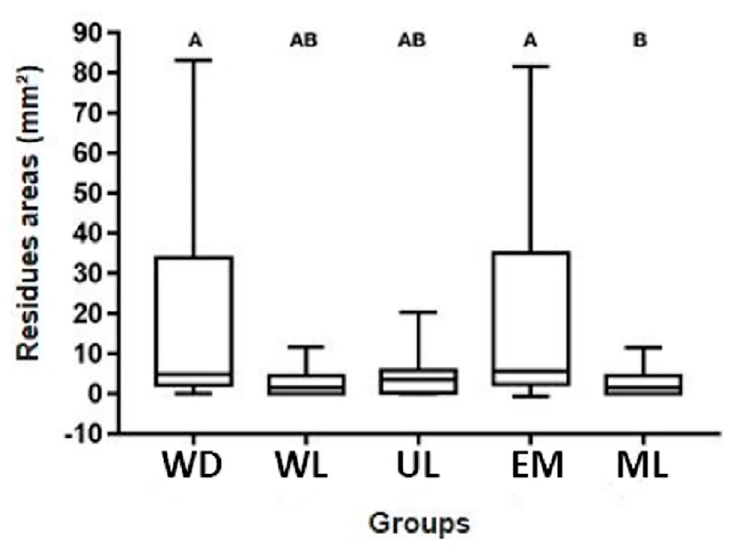
Fig 5. Box plots of the resin residues areas (mm 2 ) between T2 and T1 for each